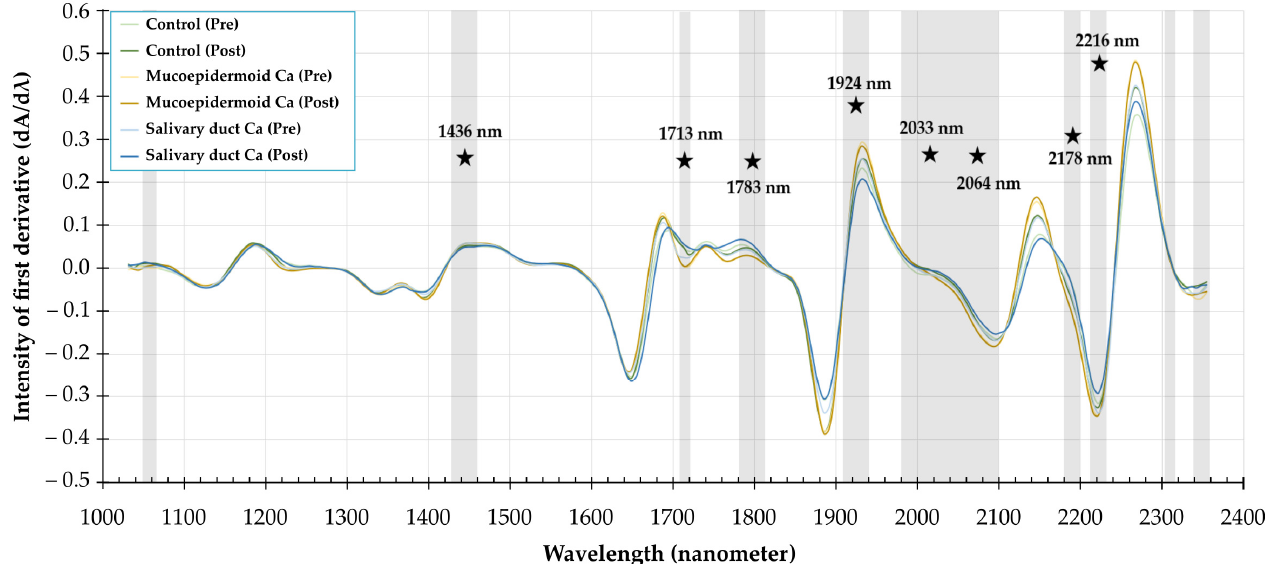
Figure 3. Discriminative spectral features in SGTs after neuraminidase treatment. The first derivatives of the median NIR spectra of SGT tissue sections pre-treatment (pre) and post-treatment (post) with α -2-3,6,8 neuraminidase are shown. Grey boxes on the spectra indicate the statistically significant wavelengths between the pre-and post-treatment group (Wilcoxon signed ranked test). The star symbols mark the position of most statistically significant wavelengths in the NIR spectrum. Ca, carcinoma.